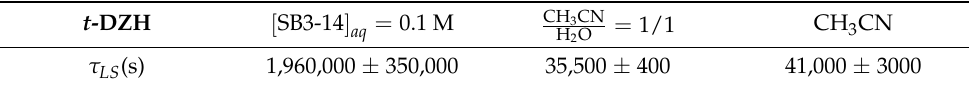
Figure 7. Trends of the absorbance at one specific wavelength for DZ that photo-isomerizes from trans -to- cis in the portion of absorbance that decays and isomerizes thermally from cis -to- trans in the portion of absorbance that grows. Graphs ( A – C ) refer to DZ in CH 3 CN, H 2 O/CH 3 CN = 1/1, and aqueous micellar solution of [SB3-14] = 0.1 M, respectively. The cyan curves are the functions fitting only the growth that corresponds to the thermal isomerization. Table 6. Lifetimes ( τ LS ) of c -DZ determined in the three media by fitting the thermal isomerization kinetics of Figure 7 through the function of Equation (11) and the least-squares